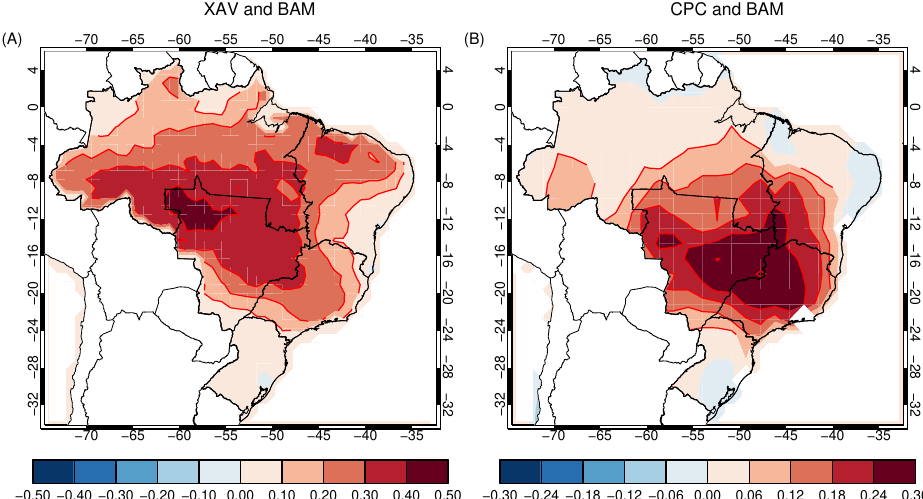
Figure 4. Correlation between the precipitation data in relation to the XAV and BAM ( A ) and the CPC and BAM ( B ) (1990–2015). The observed and modeled simulated precipitation data (shaded) and the Student’s t -test significance (95% confidence) (red